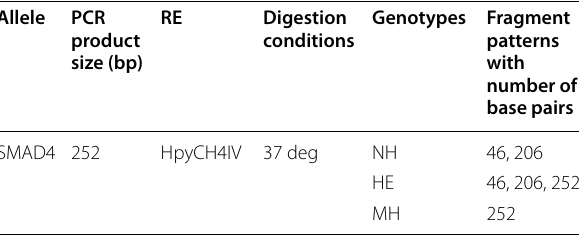
Table 3 Name of the allele, PCR product size, and restriction enzyme, length of the expected and observed fragments on digestion for SMAD4 Gene rs10502913